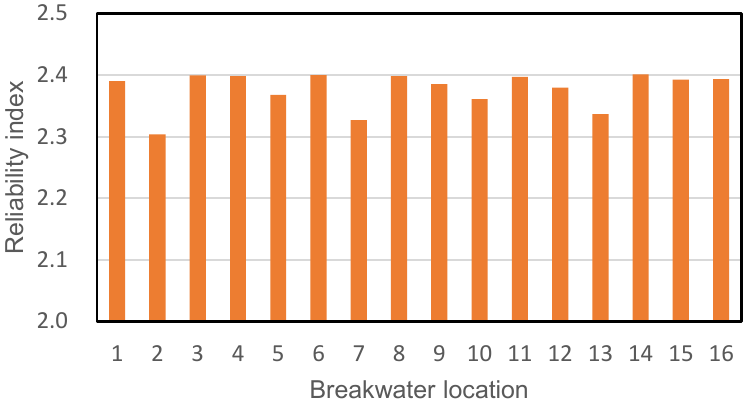
Figure 8. Reliability indices after redesign (sliding).